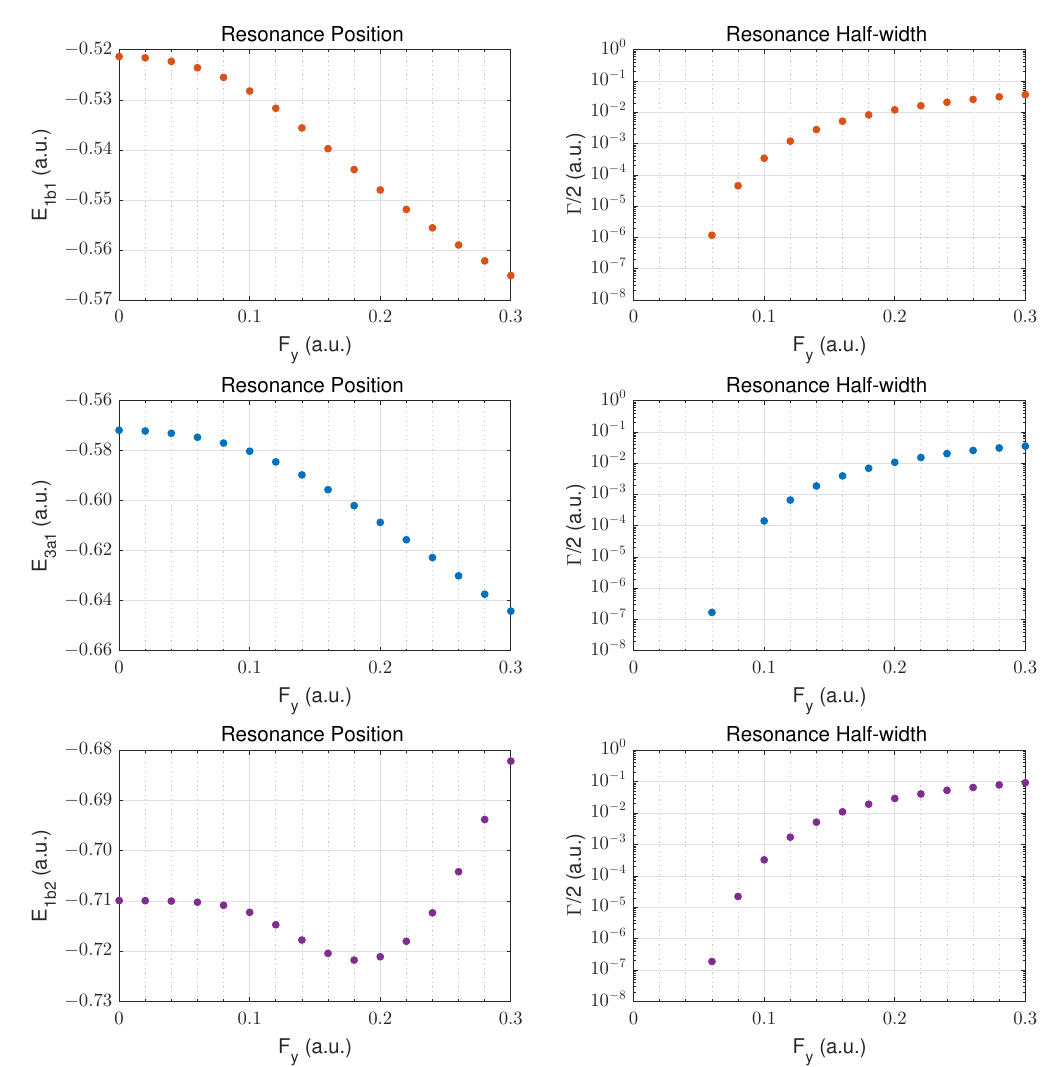
Figure 5. The left panel contains the resonance positions while the right panel contains half-widths. Here, F y > 0 corresponds to a force experienced by the electron in the positive y